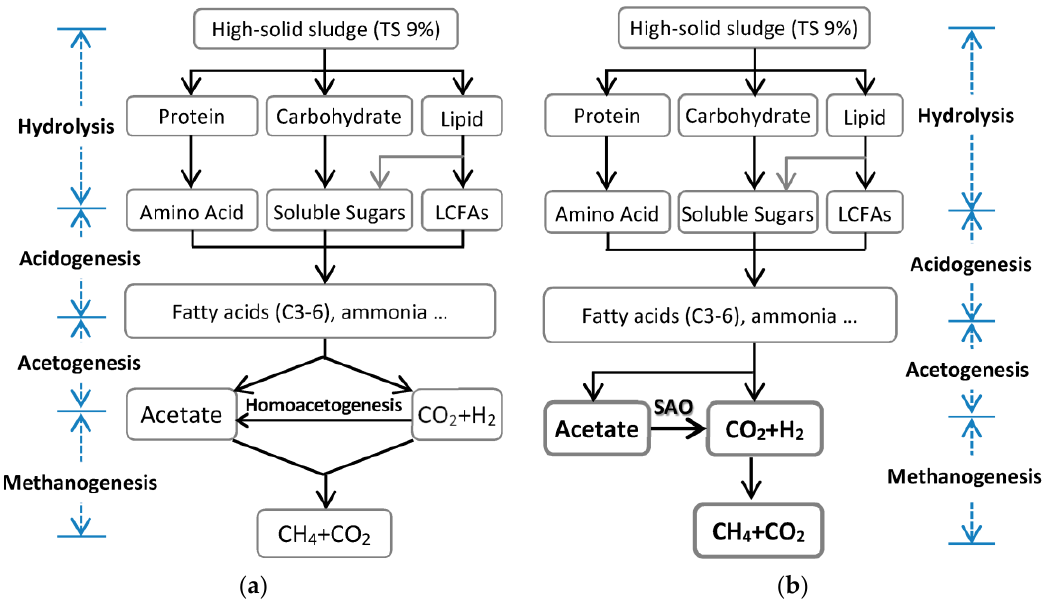
Figure 4. Scheme of ( a ) classic anaerobic digestion theory and ( b ) possible conversion route of sludge to methane in the high-solid anaerobic digestion (HSAD) system.